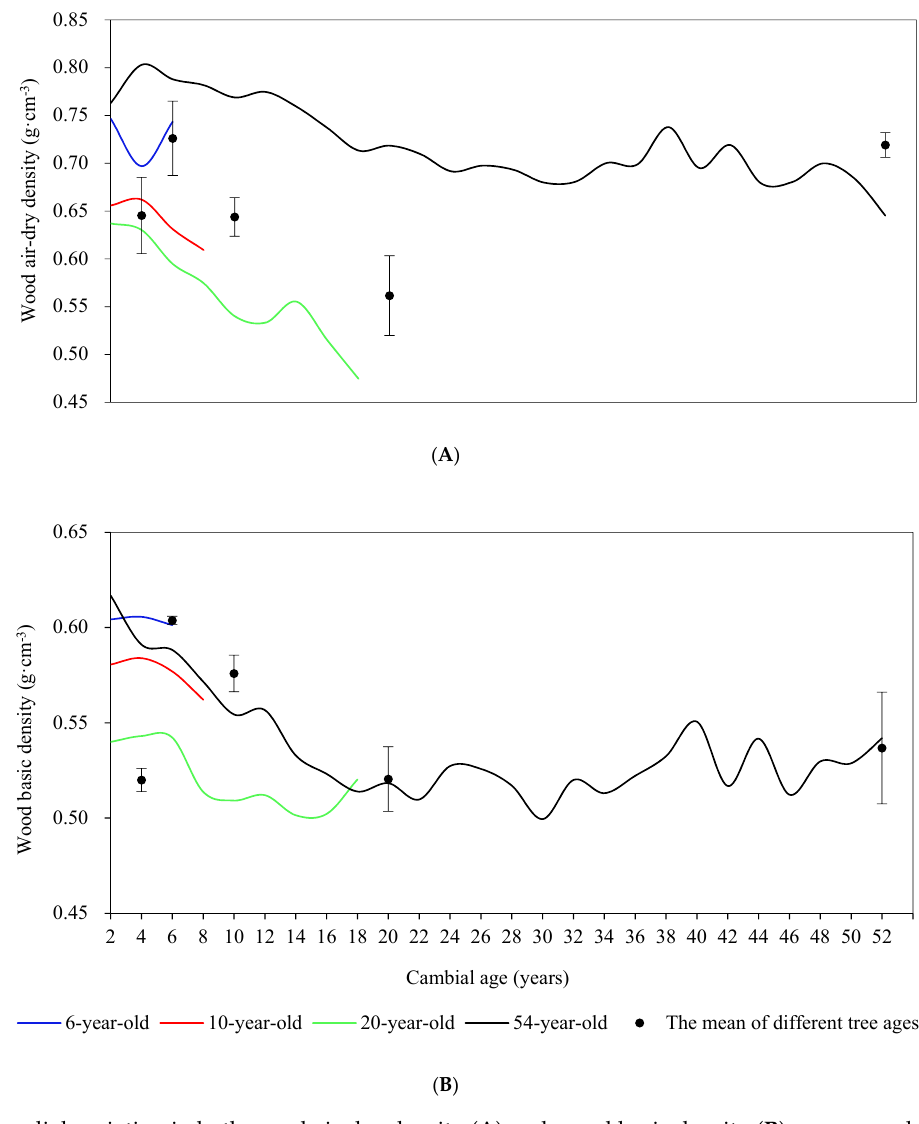
Figure 3. The radial variation in both wood air-dry density ( A ) and wood basic density ( B ) versus cambial age and the mean of different tree ages in S. superba.